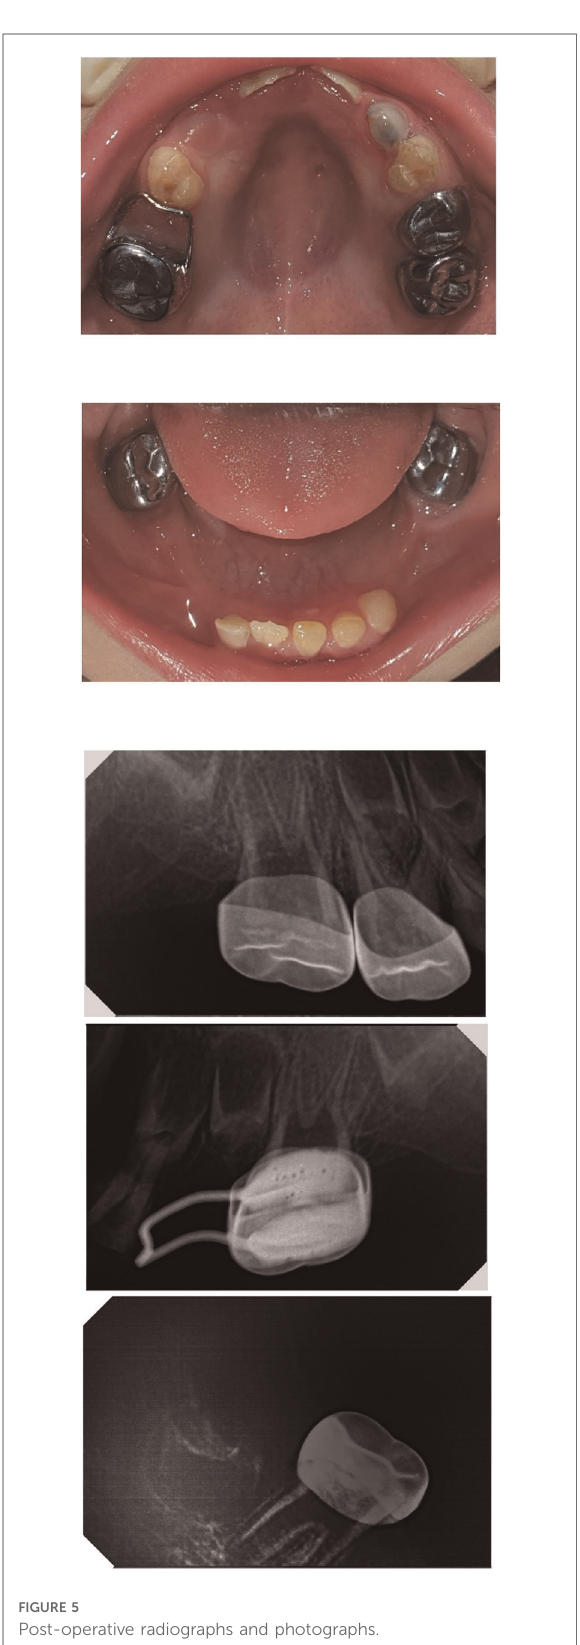
FIGURE 5 Post-operative radiographs and